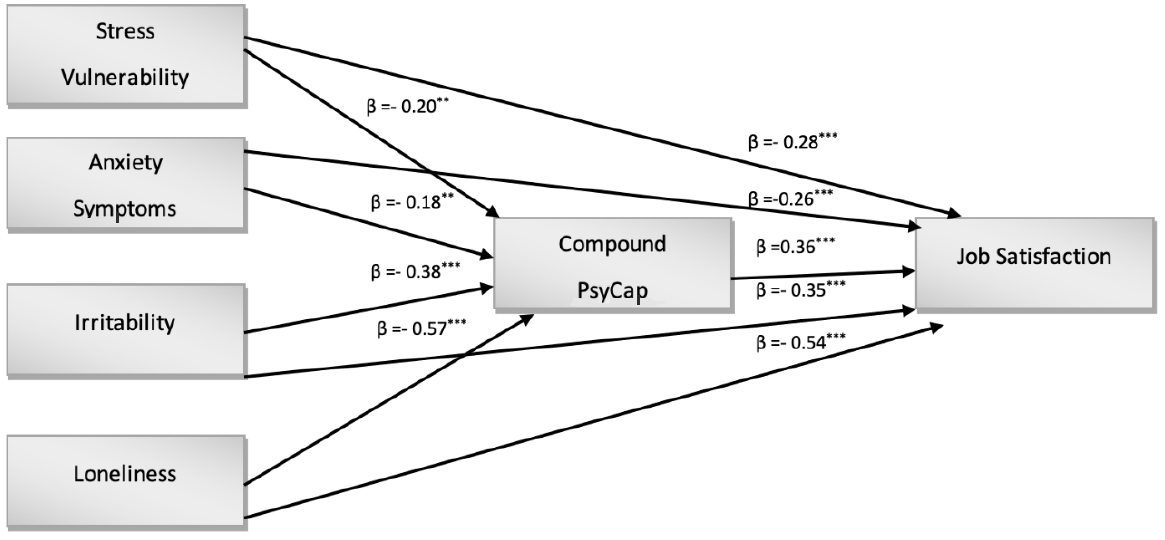
Figure 1. Structural model *** p < 0.001, ** p < 0.01. Table 3. Standardized indirect effects from Stress Vulnerability, Anxiety Symptoms, Irritability